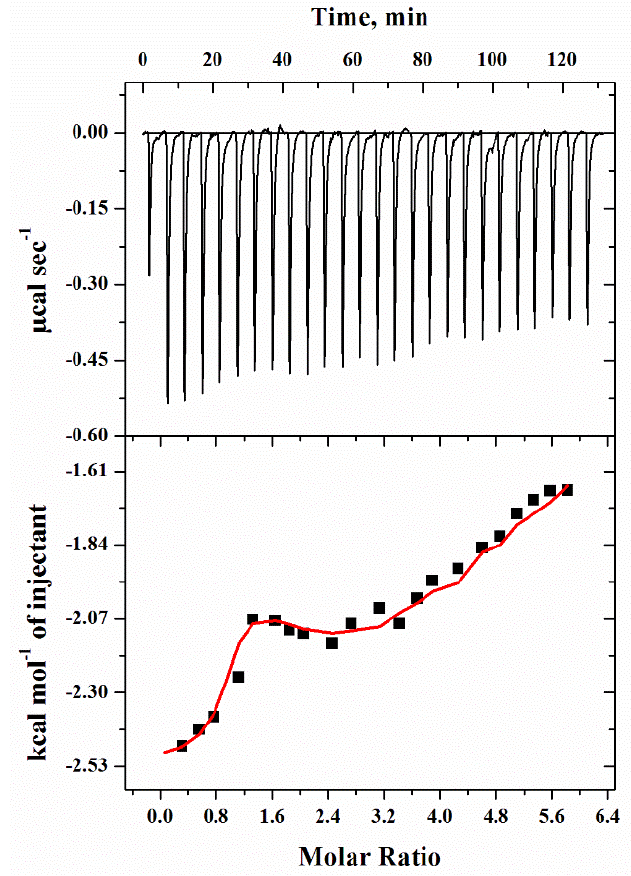
Figure 6. Isothermal titration calorimetry (ITC) profile of tyrosinase-santalol binding: calorimetric responses owing to consecutive injections of santalol in the ample cell with tyrosinase are depicted in upper section, while the lower section depicts integrated heats of interactions as the function of the [santalol]/[tyrosinase] molar ration. Table 2. Calorimetric binding parameters obtained by analysis of ITC measurements on interaction of santalol with purified tyrosinase at 25 ◦ C) and pH